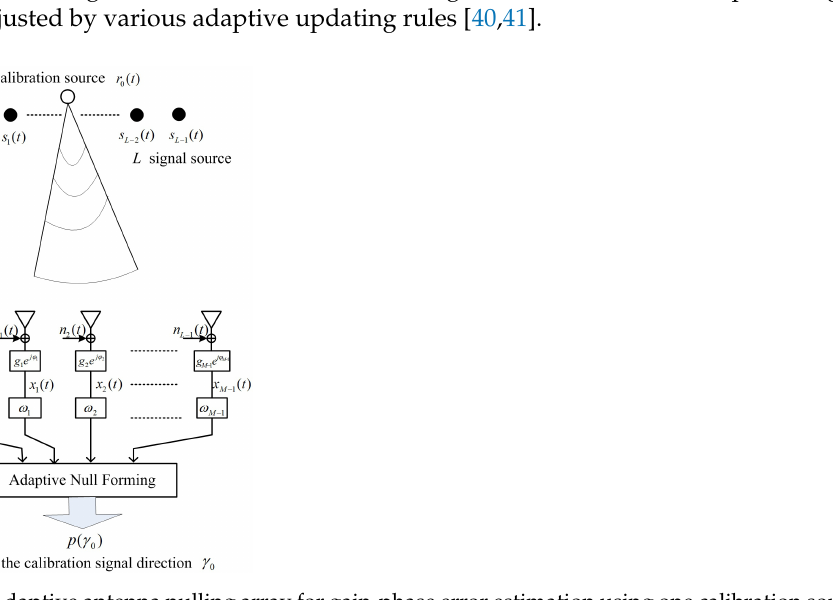
Figure 1. Adaptive antenna nulling array for gain-phase error estimation using one calibration